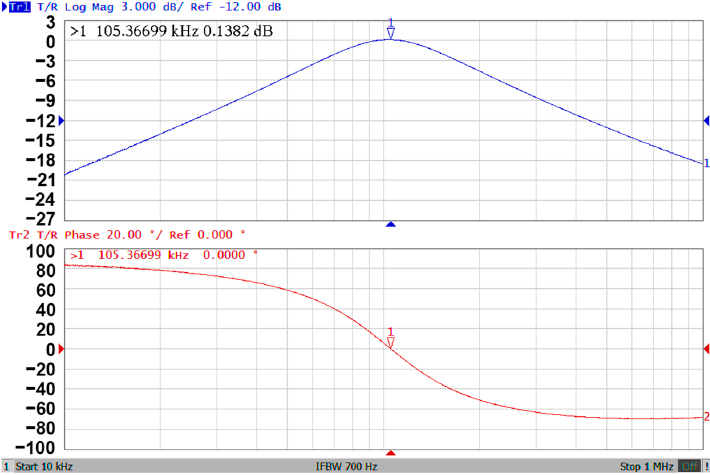
Figure 9. The experimental results of gain and phase responses of the BPF in Figure 2. Sensors 2020 , 20 , x FOR PEER REVIEW